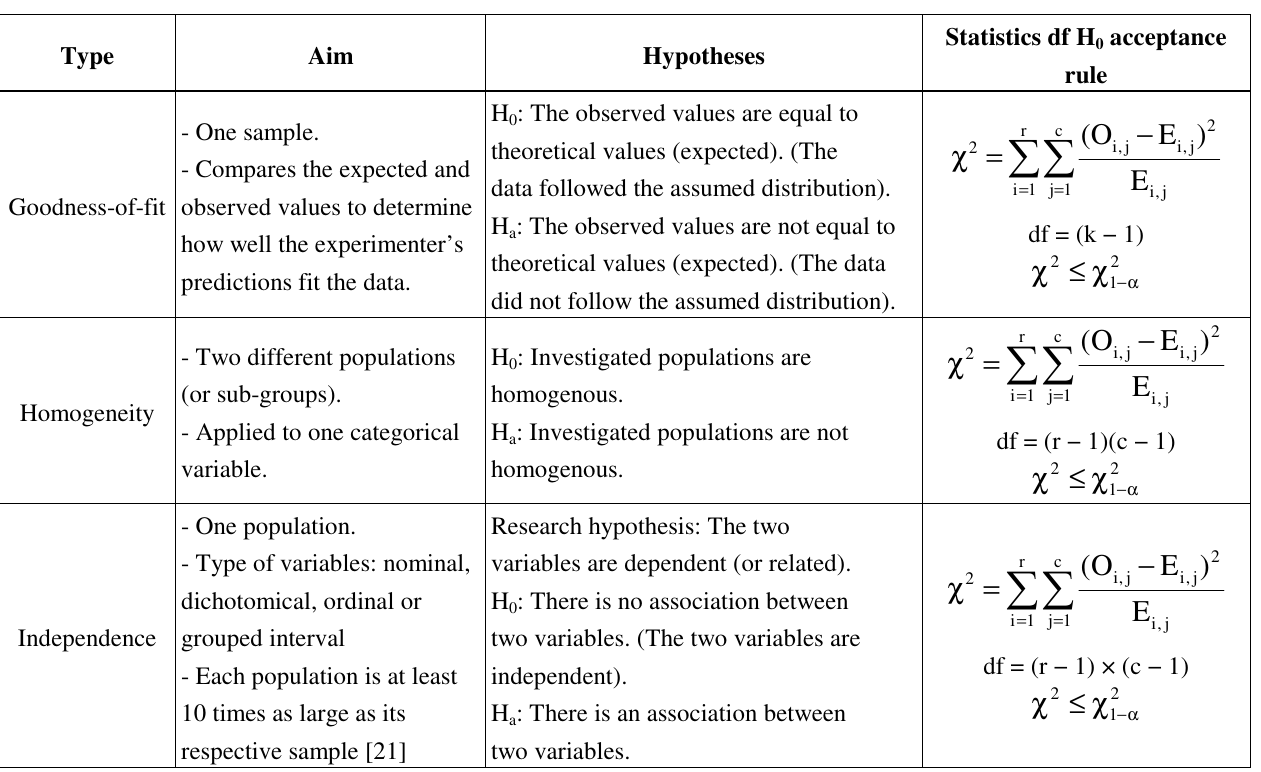
Table 1. Summary of Chi-square